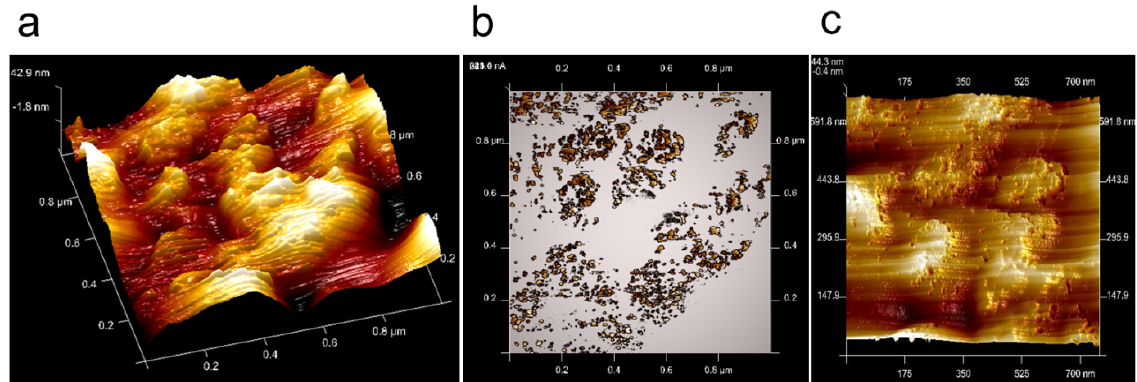
Figure 6. ( a ) AFM image of Nafion ® 112 under current flow with a 3-dimensional view of the topography after the Nafion was activated in an electrolysis setup; the image size is 1 µm × 1 µm. ( b ) Simultaneous measured current image; the current values are of the order of 300–600 nA. ( c ) Overlay of the current image onto the topography. Current flow is observed at edges of the swollen regions.